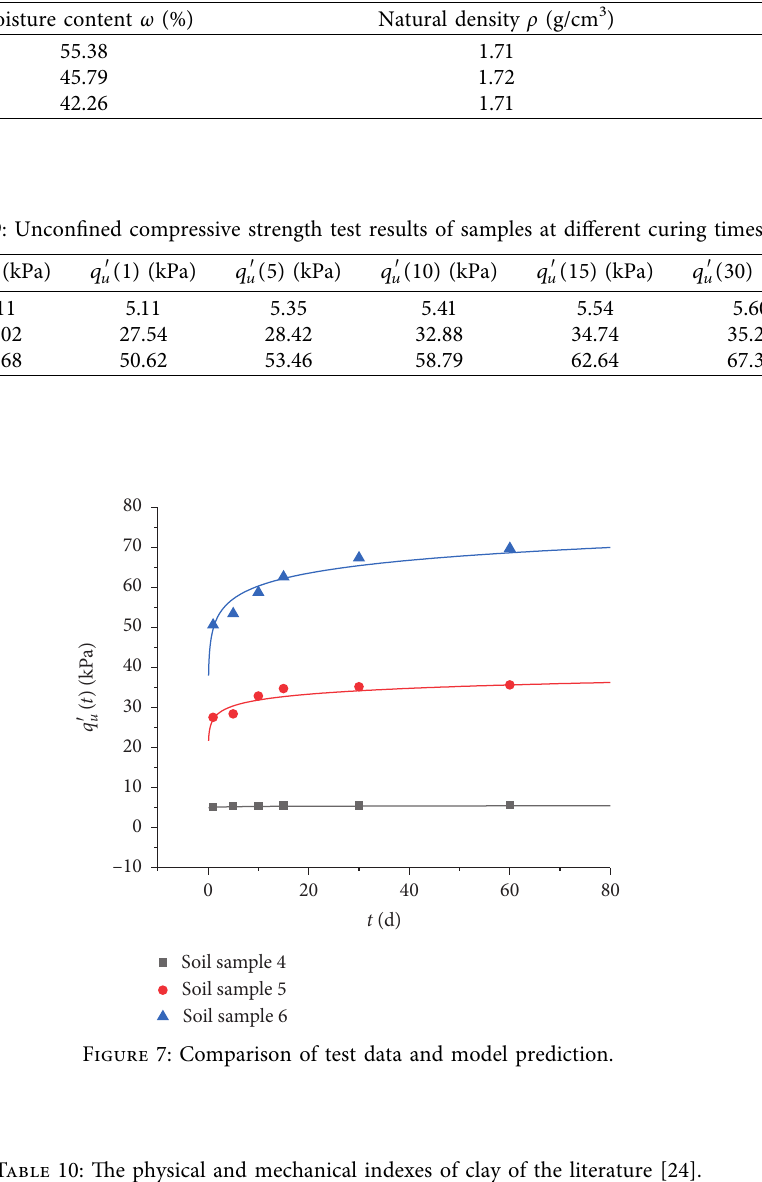
Table 8: The test results of physical properties of Zhanjiang Formation clay.